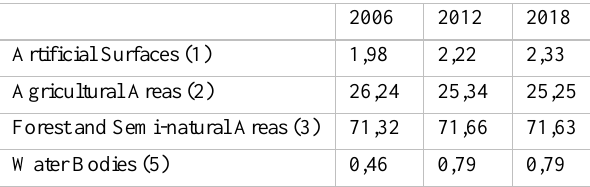
Table 1. Temporal percentage change of LULC according to the CORINE land cover index